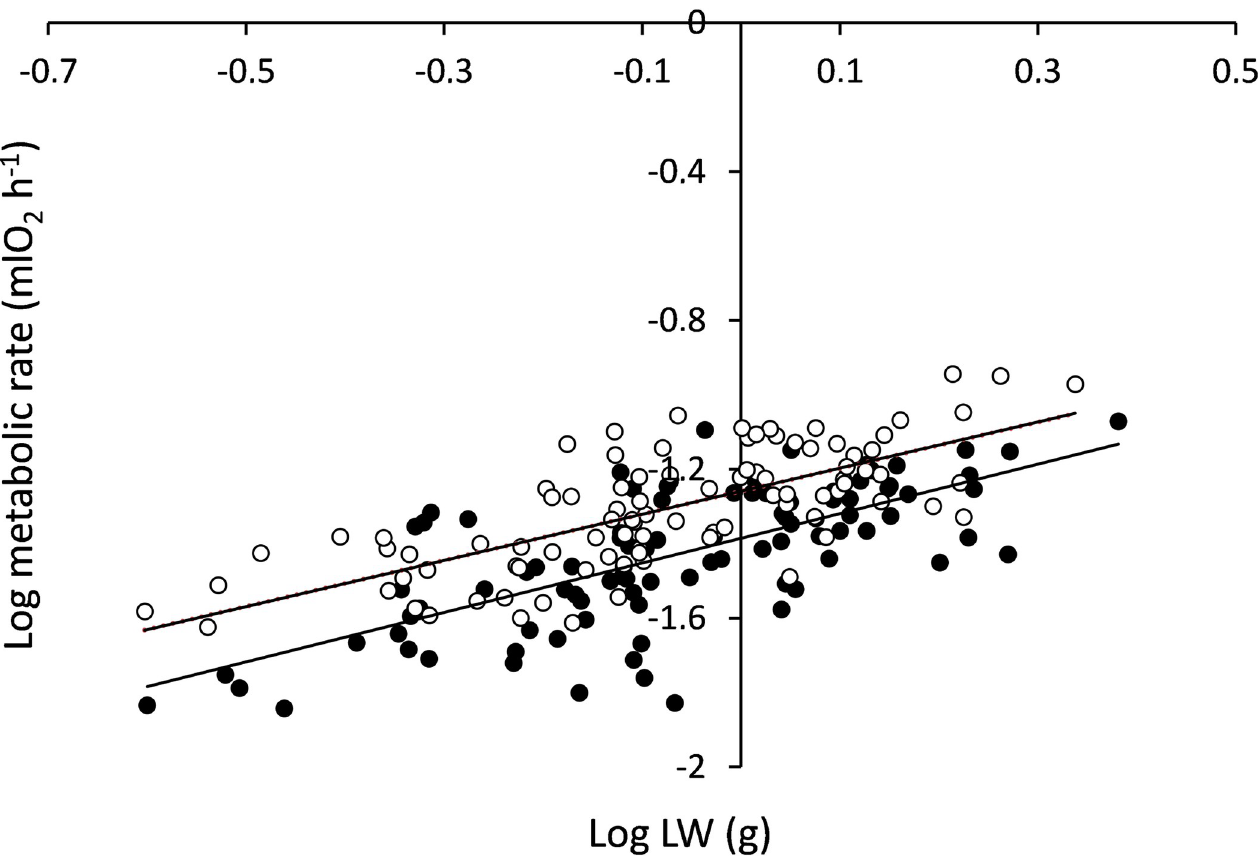
Fig 6. Log-log regression lines for routine metabolic rate (RMR: Upper line; hollow symbols) and standard metabolic rate (SMR: Lower line; full symbols) vs live weight (LW). Interindividual analysis performed on day 119 in mussels from Group 1 .